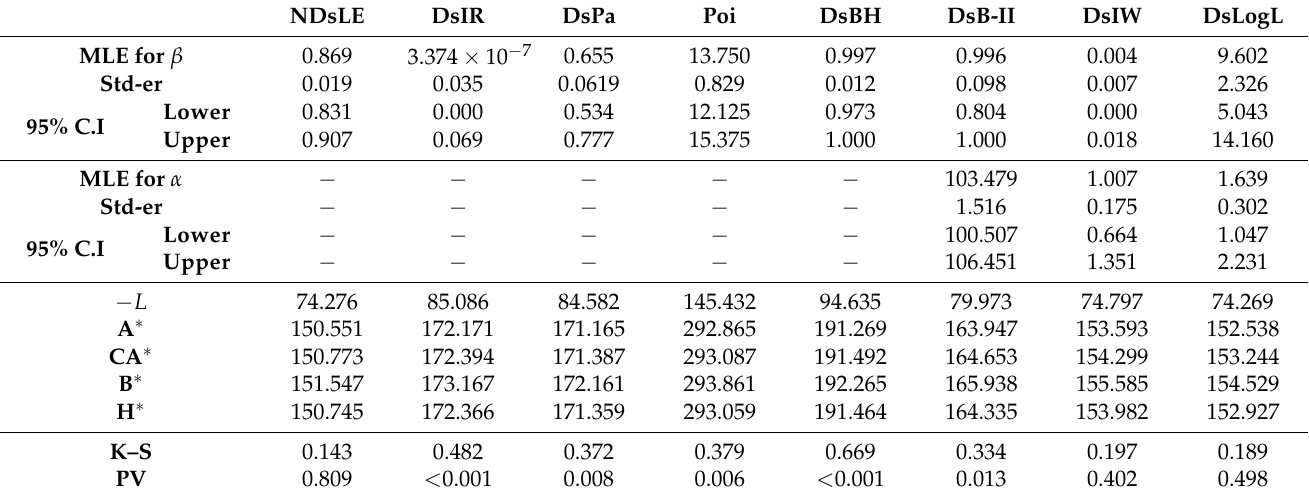
Table 15. The MLEs, Std-er, C.I, and GOF measures for data set